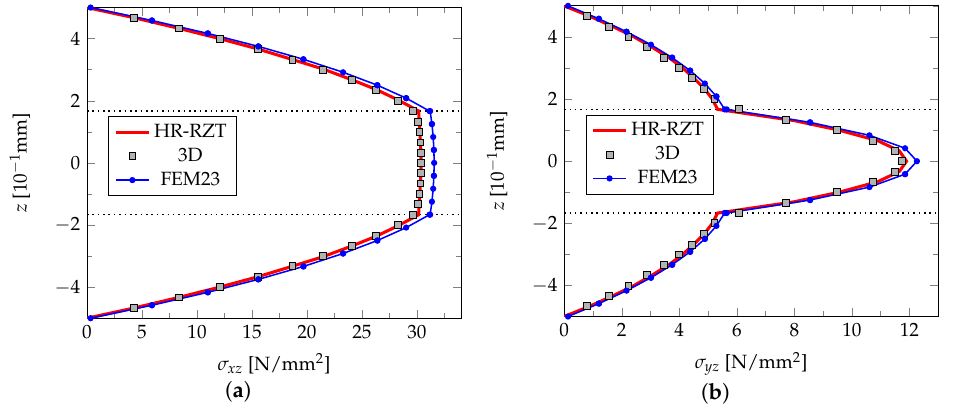
Figure 10. Example 3: shear stress along the plate thickness σ xz ( 3/7 l ,0, z ) ( a ) and σ yz ( 0,3/7 l , z ) ( b